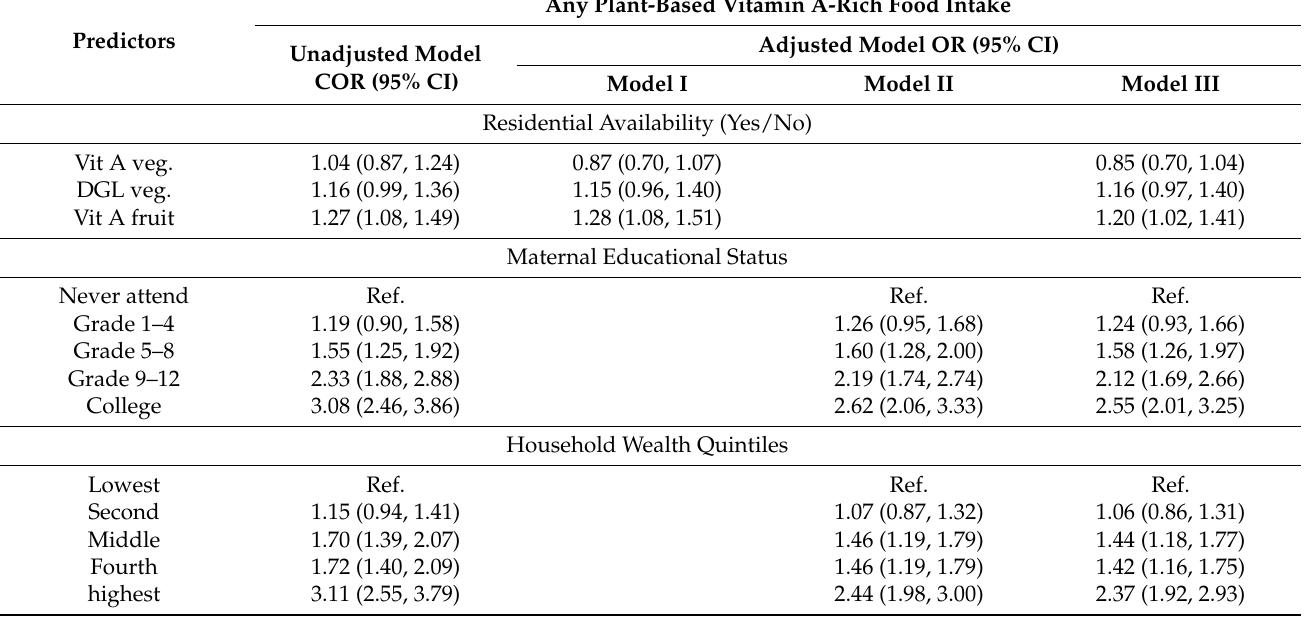
Table 4. Unadjusted and adjusted multilevel logistic regression result of the predictors of